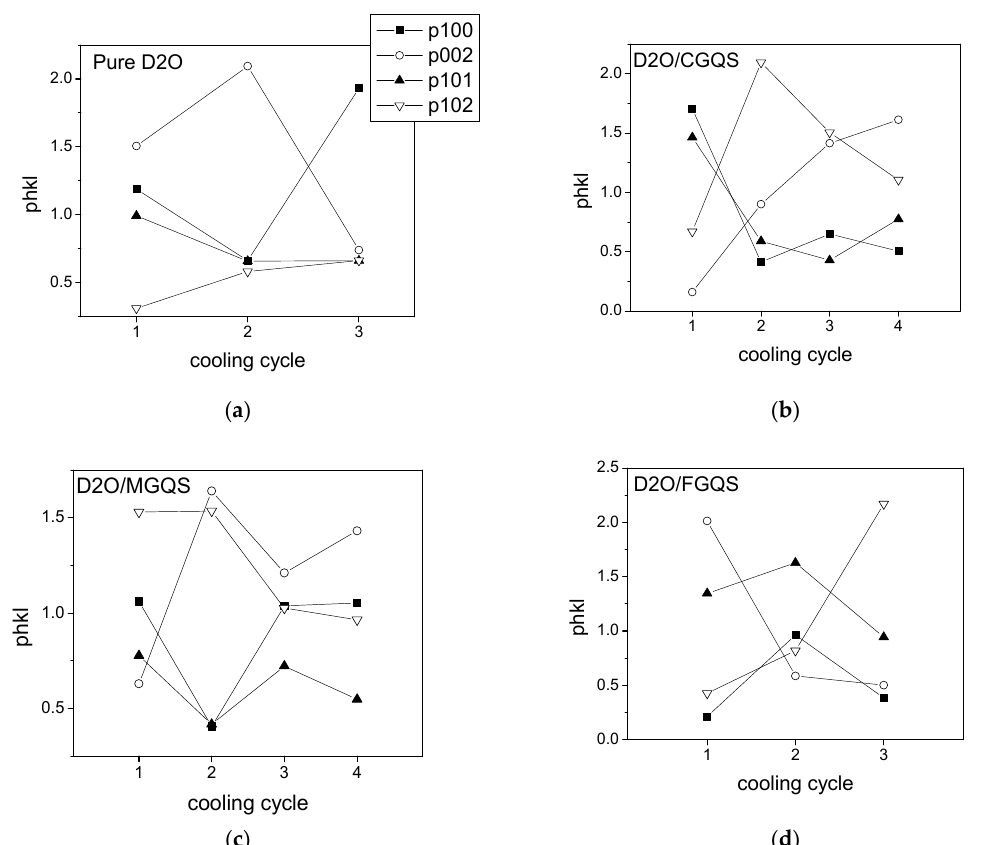
Figure 2. Evolution of p hkl , hkl = 100, 002, 101, 102 during the successive thermal cycles (see the text for details) observed for the indicated sample types: ( a ) pure D 2 O, ( b ) CGQS, ( c ) MGQS, ( d ) FGQS. The pure D 2 O and D 2 O/FGQS specimens were subjected to 3 consecutive cooling–heating cycles, the D 2 O/MGQS and D 2 O/CGQS then to 4 cycles.